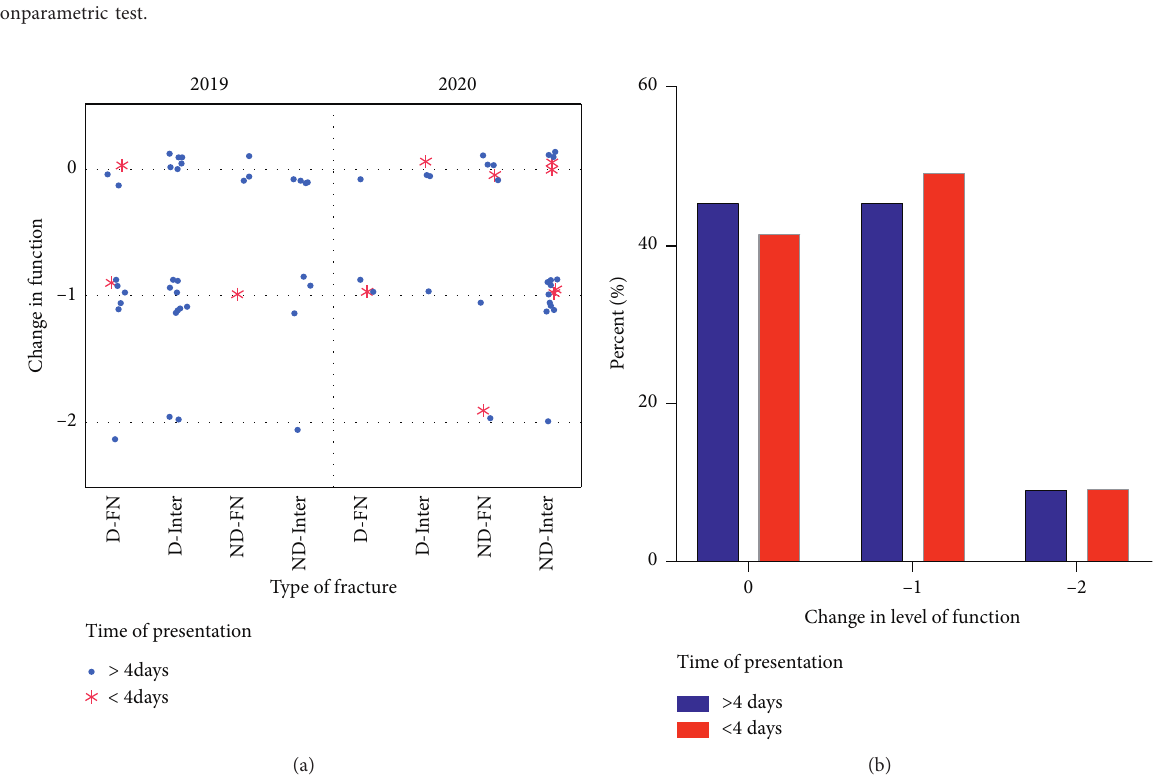
Figure 1: Changes in function resulting from hip fractures. (a) Comparison of the categorical change in function for each type of fractures. Change in function was assigned a value based on the mobility capacity before fracture and after fracture. A zero indicates no change from pre- to postfracture; negative one indicates a one-level decrease in function (i.e., from previously walking to using aid to walk); and negative two indicates a two-level decrease in function (i.e., from previously walking to being bedridden). No significant differences in functionality were observed between years. (b) The percent of patients within each categorical change in functionality was not affected by the delay in presentation (data collapsed across years). D � displaced, ND � nondisplaced, FN � femoral neck, and Inter. �